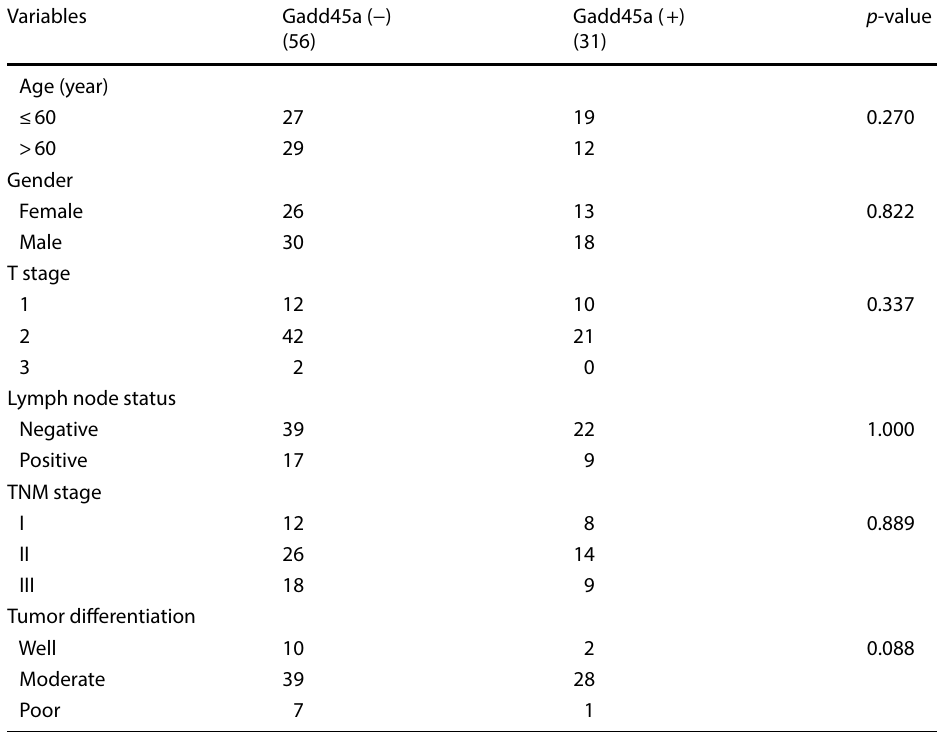
Table 1 Demographic and clinical characteristics of